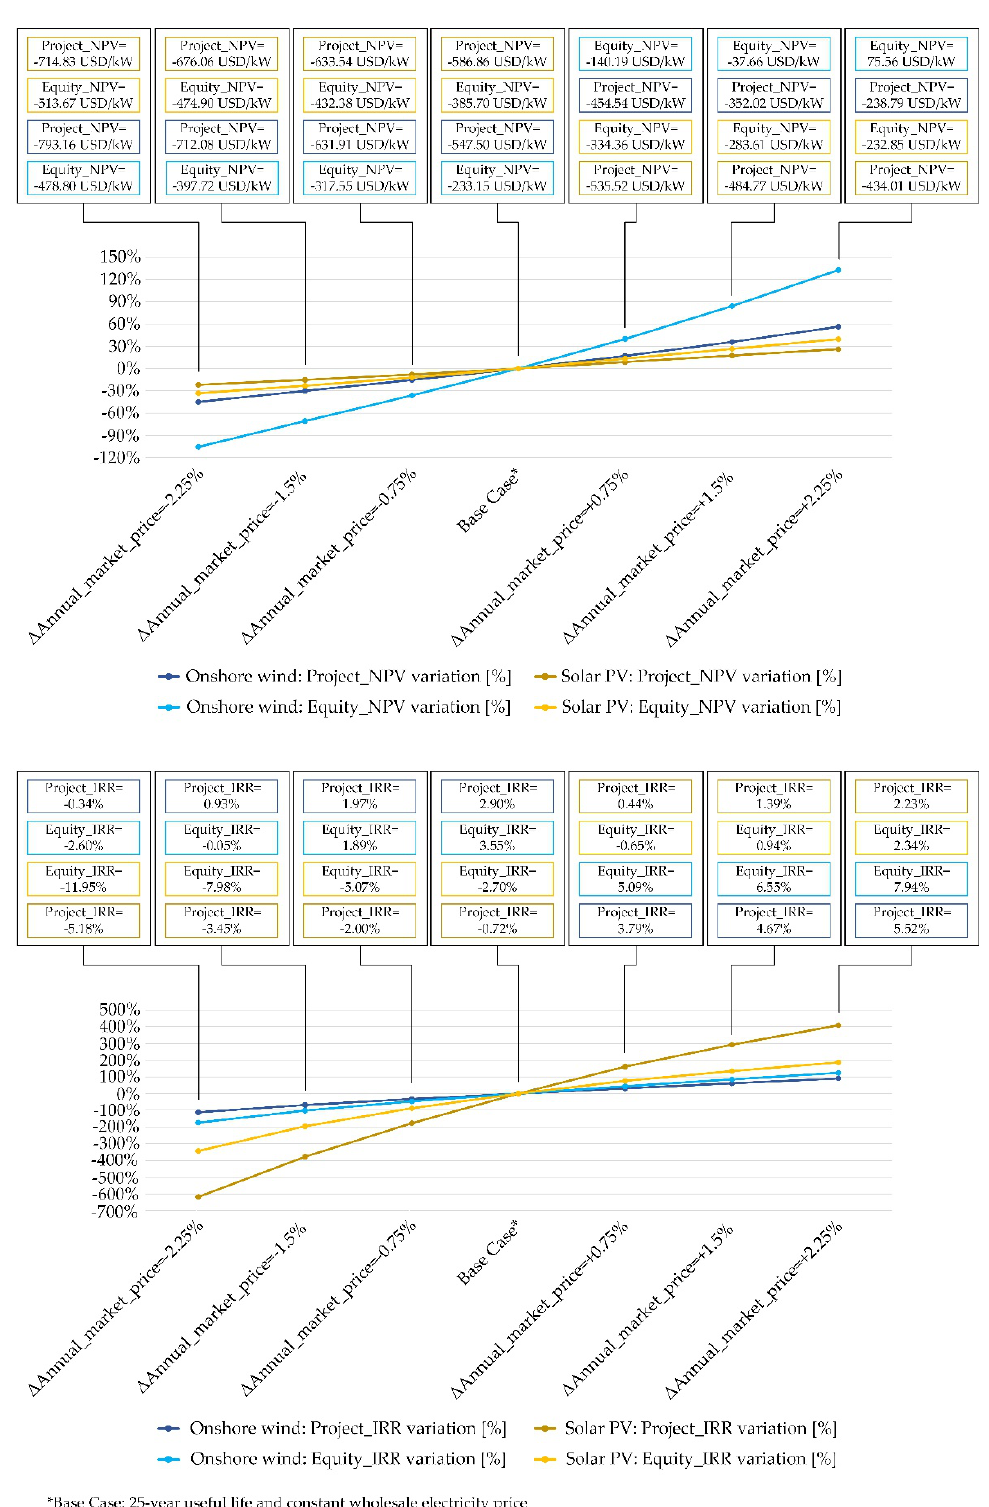
Figure 7. Project and equity NPV percentage variation (upper subplot) and project and equity IRR percentage variation (lower subplot) with annual market price percentage variation for the Danish case. Source: self ‐elaboration.